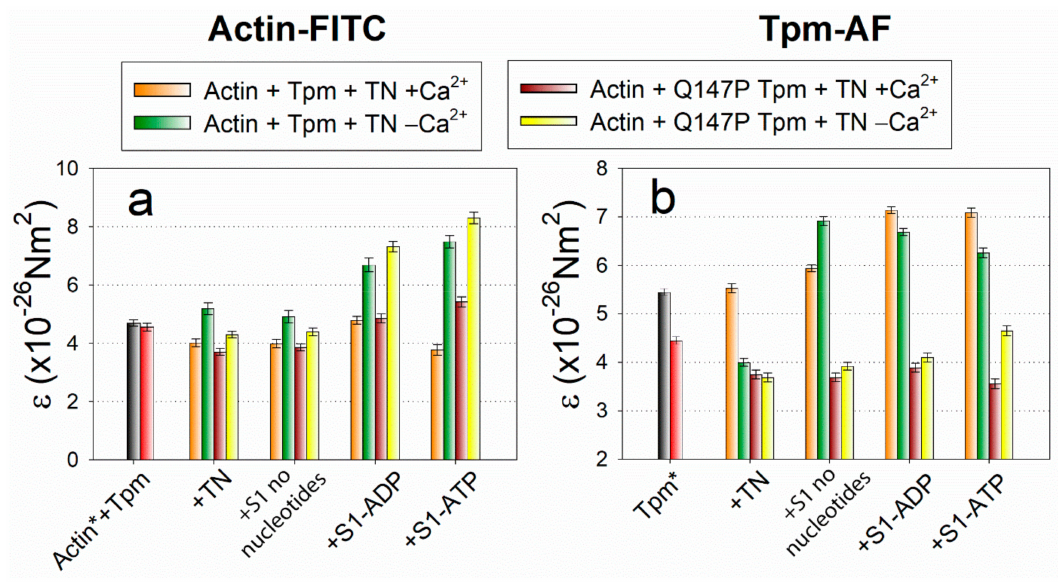
Figure 2. The changes in the value of ε —bending sti ff ness—for the fluorescent probes bound to actin (Actin-FITC, or Actin*, a ) and Tpm (Tpm-AF, or Tpm*, b ) in ghost fibers containing recombinant WT and Q147P-mutant Tpms in the absence of troponin (black and red columns) and in the presence of troponin at low and high Ca 2 + -concentrations (see legend). The increase in the value of ε means the increase in the persistence lengths of actin and Tpm